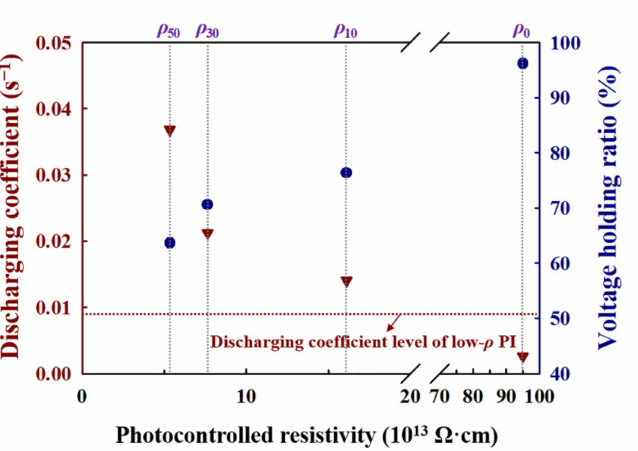
Figure 7. Trade-off between the discharging coefficient and VHR (signal voltage frequency: 0.5 Hz) properties according to the photocontrolled resistivity levels of the LC alignment PI layer in the FFS n -LC mode (fullerene doping density within the high- ρ PI: 0.05 wt%). ρ 0 , ρ 10 , ρ 30 , and ρ 50 correspond to the photocontrolled PI resistivity levels, obtained under the Ar laser irradiation intensity conditions of 0 mW · cm − 2 , 10 mW · cm − 2 , 30 mW · cm − 2 , and 50 mW · cm − 2 ,